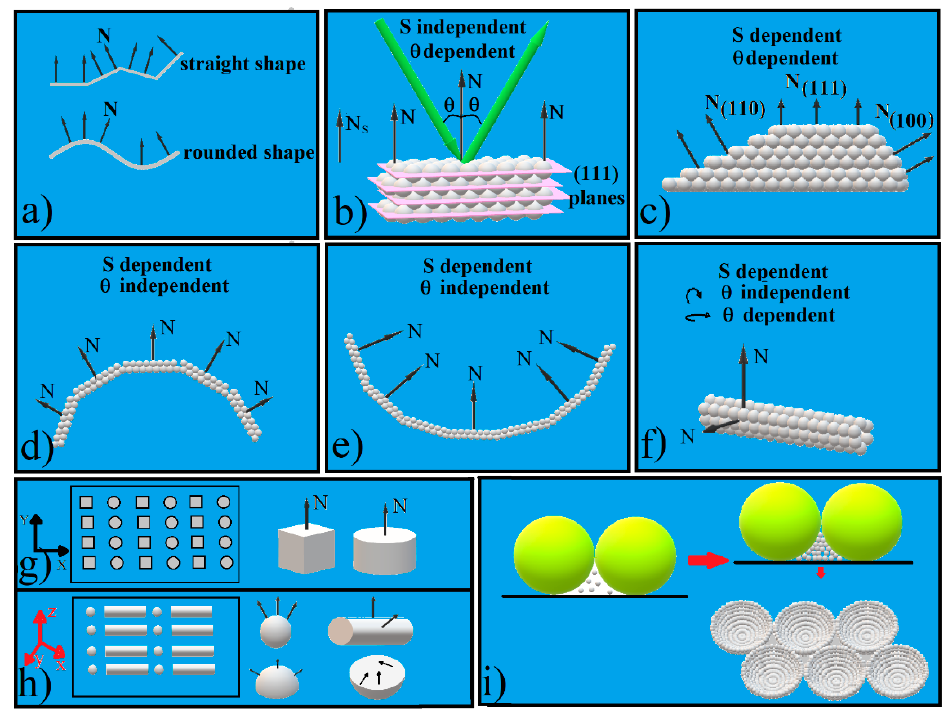
Figure 1. Schematical of: ( a ) straight and rounded shapes; ( b ) flat surfaces parallel with the substrate CC; ( c ) truncated pyramid shaped CC; ( d ) convex, hemispherical shaped CC; ( e ) concave, hemispherical shaped CC; ( f ) cylindrical shaped CC; ( g ) 2D structured patterned CC; ( h ) 3D structured patterned CC; ( i ) ordered concavity array synthesis.